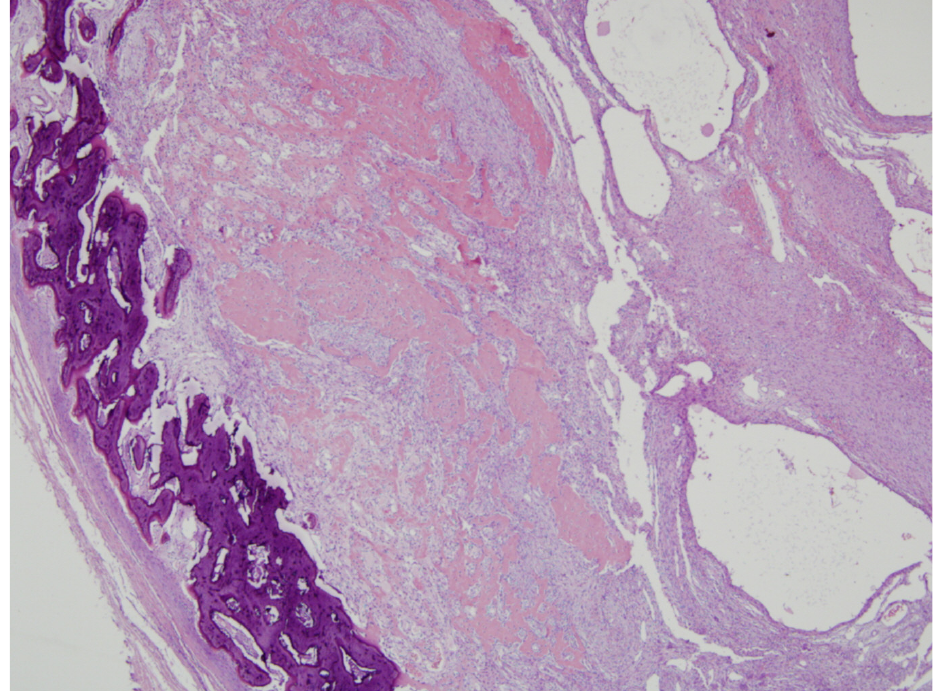
Figure 7. On histologic exam, the lesion contained a central cellular spindle cell area associated with immature woven bone formation and more organized mature lamellar bone at its periphery, which was consistent with myositis ossificans.